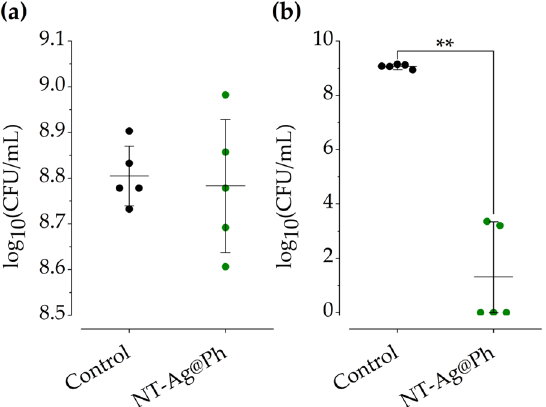
Figure 5. The effect of NT-Ag@Ph against ATCC27853 wound-like medium at 125 µg/mL ( a ) and 2 mg/mL ( b ). The control (black) and NT-Ag@Ph (green) are shown. ** p < 0.01 for Mann–Whitney test.